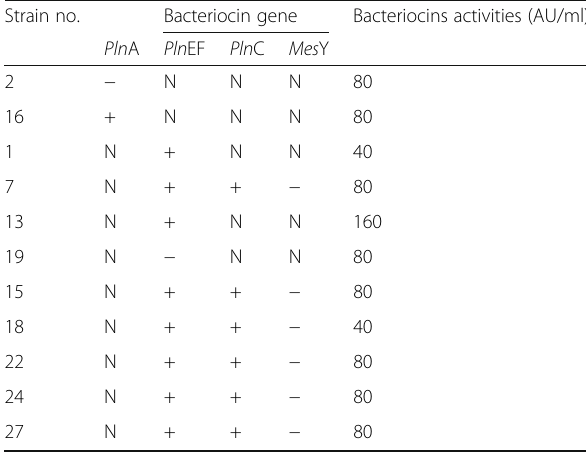
Table 5 PCR amplification of bacteriocin genes from Lb . plantarum and Lc . mesenteroids isolates Strain